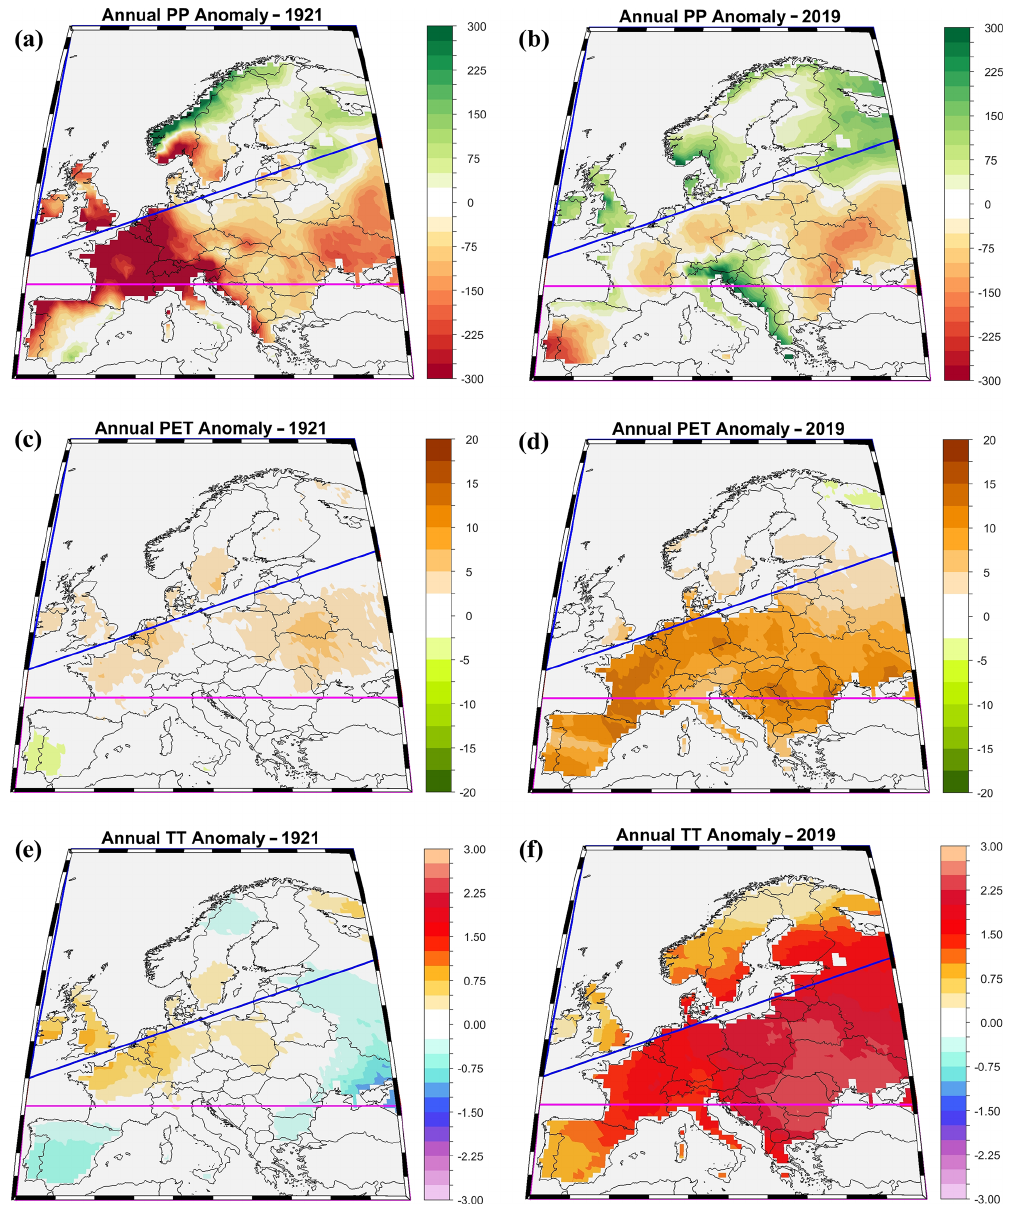
Figure 10. Yearly anomalies for (a) PP–1921, (b) PP–2019, (c) TT–1921, (d) TT–2019, (e) PET–1921, and (f) PET–2019. The anomalies are computed relative to the period